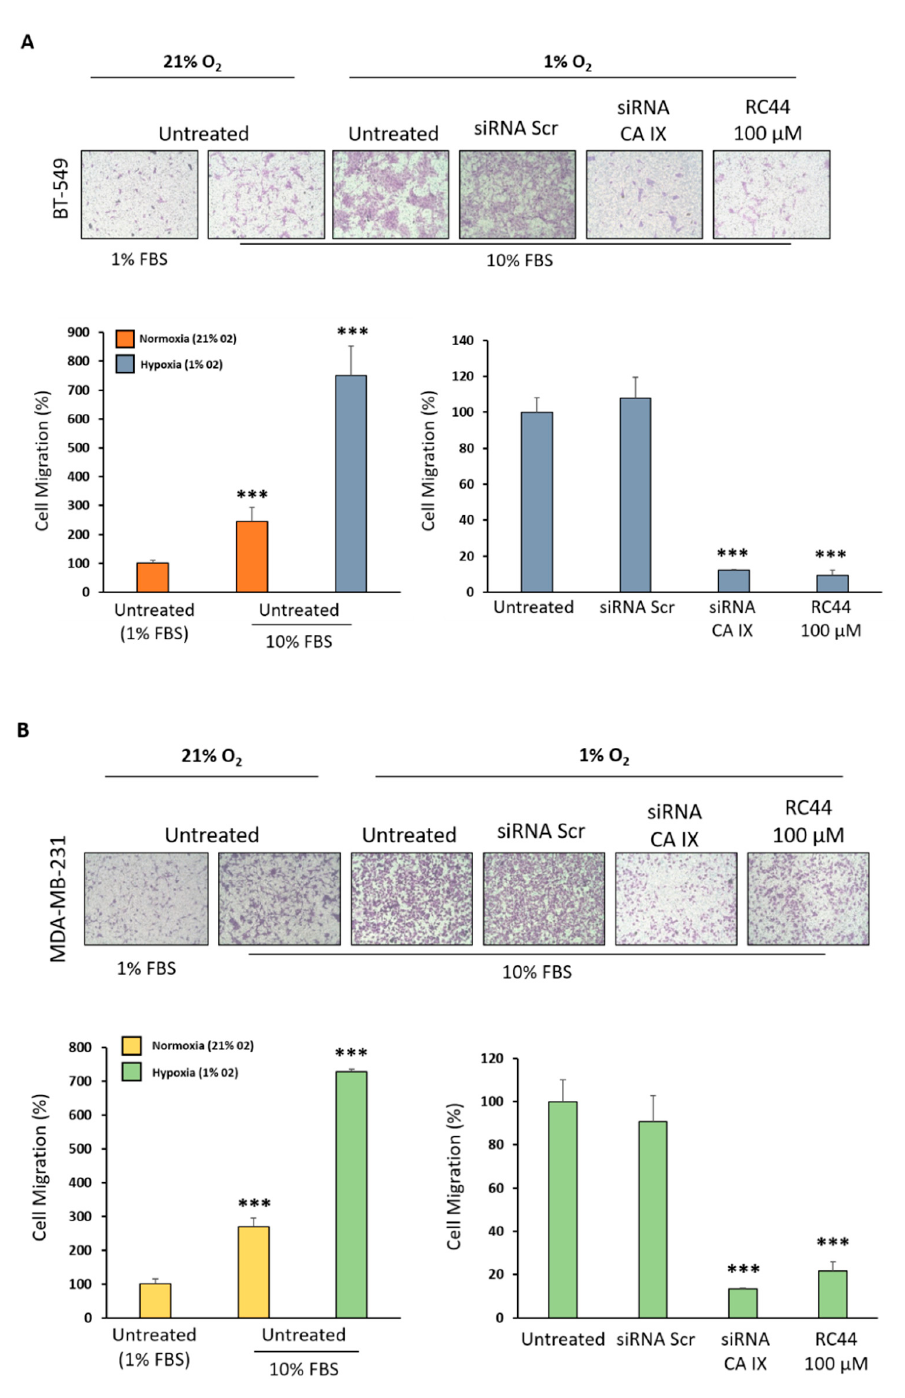
Figure 4. Targeting CA IX hampers TNBC cell migration. Boyden chamber was used for migration assay. BT-549 ( A ) and MDA-MB-231 ( B ) were grown in normoxia (21% O 2 ) or hypoxia (1% O 2 ) conditions and migration was analyzed. Medium containing 1% FBS or 10% FBS was added to the lower chamber as chemoattractant. The results are expressed as the percentage of migrating cells considering the untreated control sample (1% FBS) as 100%. TNBC cells grown in 1% O 2 were transfected with siRNA CA IX (100 nM) and siRNA Scr (100 nM) or treated with RC44 (100 µ M) and seeded in the upper chamber. Medium containing 10% FBS was added to the lower chamber as chemoattractant. The results are expressed as the percentage of migrating cells considering the untreated control sample (10% FBS) as 100%. Bars depict mean ± SD of three independent experiments. *** p <